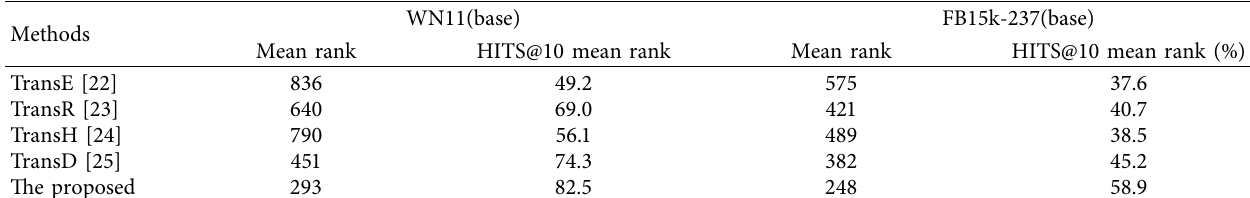
Table 3: Comparison of experimental results on entities link prediction.